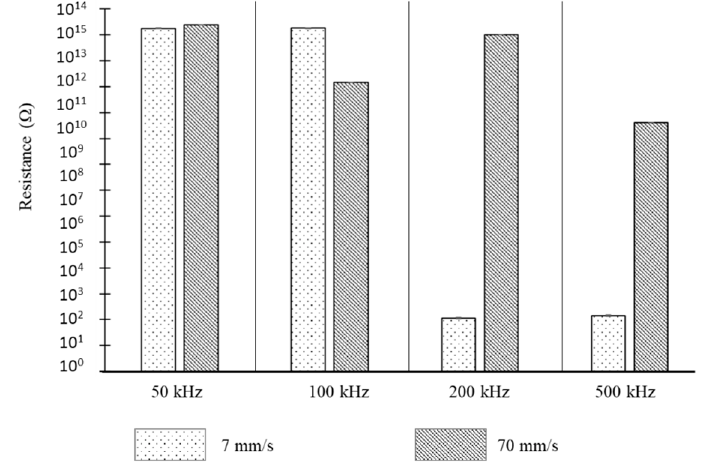
Figure 9. Electrical resistance results and their variation for a PI material with linear absorption using laser scanning processing.